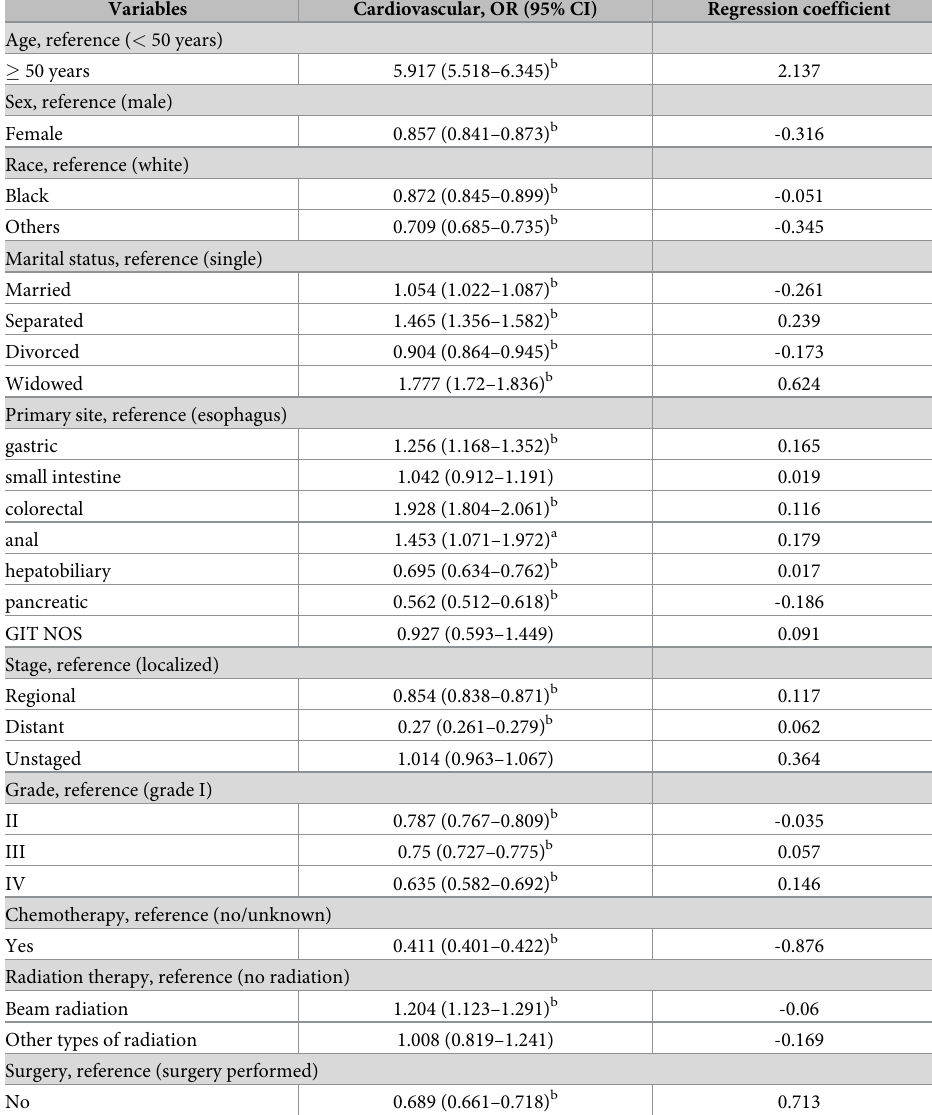
Table 4. The probability of cardiovascular disease using binary logistic regression